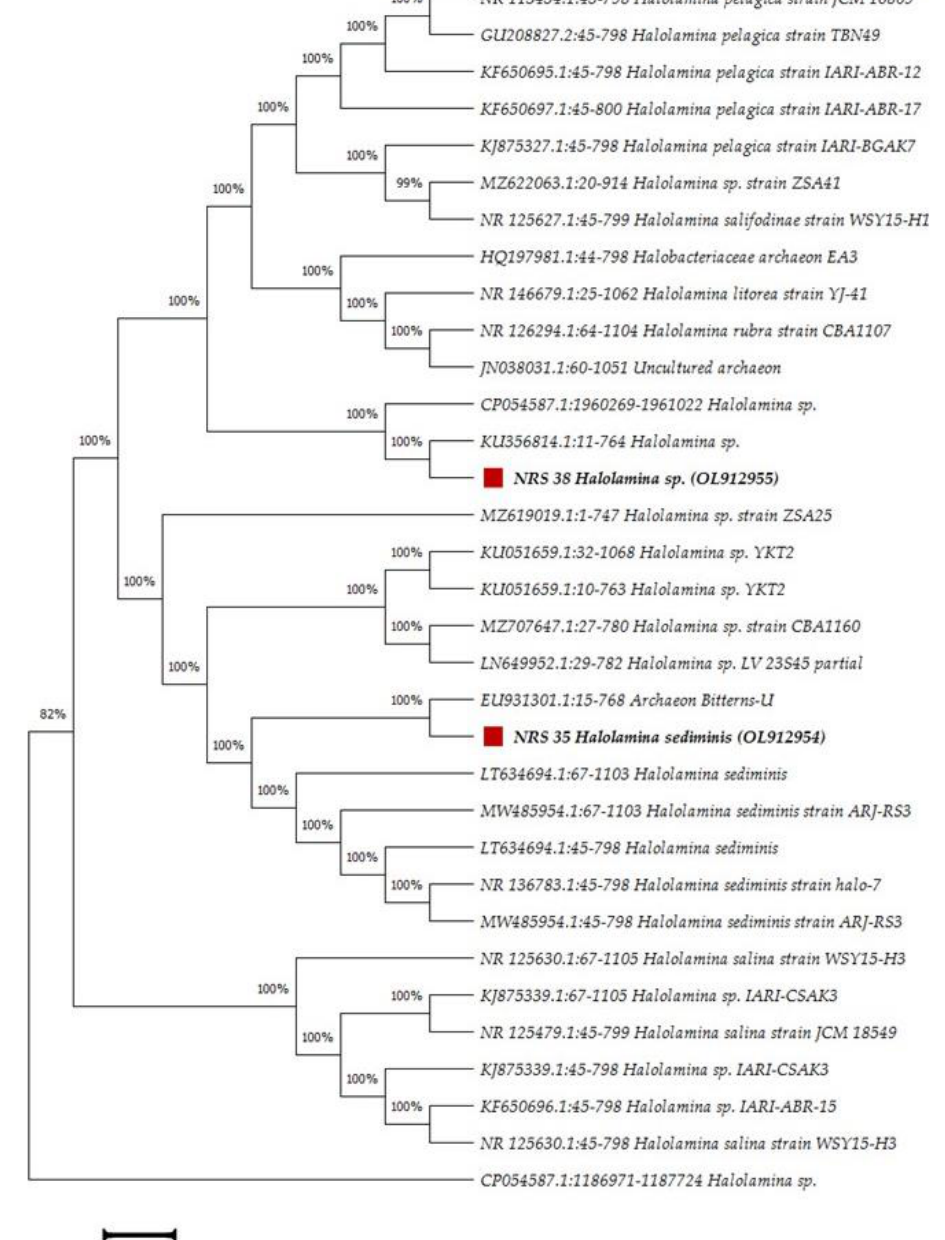
Figure 1. Maximum likelihood phylogenetic tree based on 16S rRNA gene sequences showing the relationship between the potential PHB-producers NRS_35 and NRS_38 and closely related species from the GenBank database. The scale bar indicates 0.02 substitutions per nucleotide position.